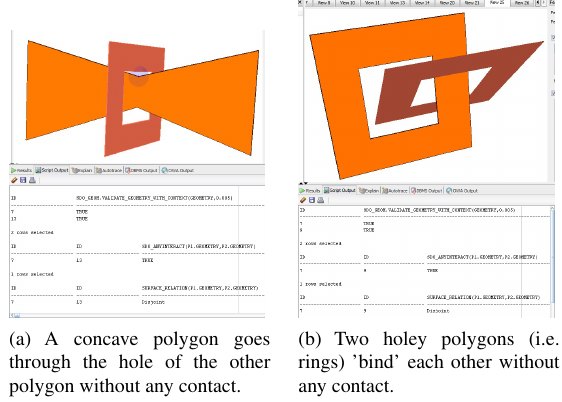
(a) A concave polygon goes (b) Two holey polygons (i.e. through the hole of the other rings) ’bind’ each other without polygon without any contact. any contact. Figure 15: Two tests that ANYINTERACT cannot function prop- erly, while our operator returns the the expected